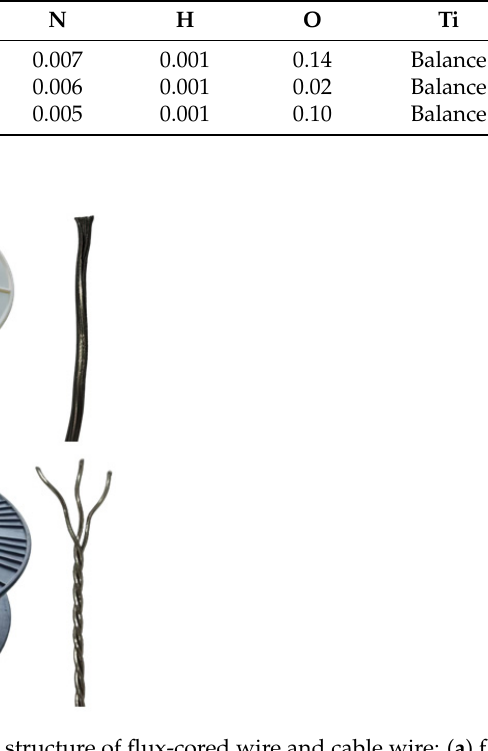
Figure 1. Comparison of the morphology and structure of flux-cored wire and cable wire: ( a ) flux-cored wire; ( b ) cable wire.